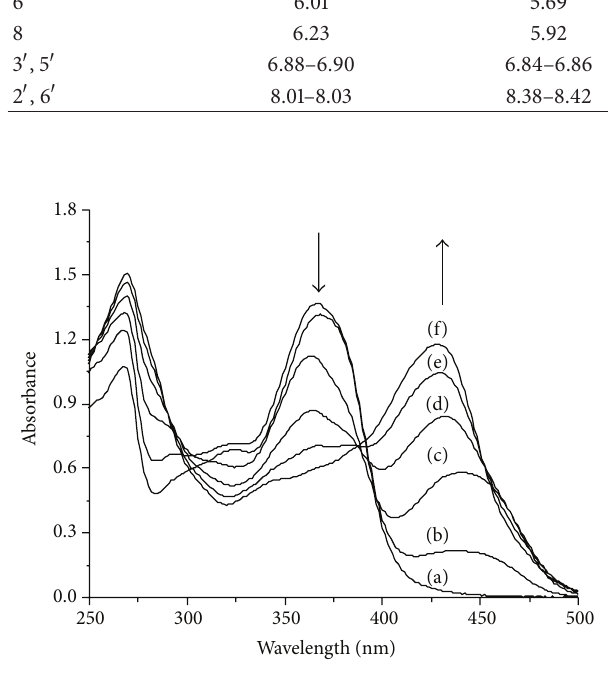
Figure 1: Absorption spectra of ligand L in ethanol in the presence of La (III). The molar ratios [La(NO 3 ) 3 ]/[ligand] = 0 (a), 0.2 (b), 0.4 (c), 0.6 (d), 0.8 (e), and 1.0